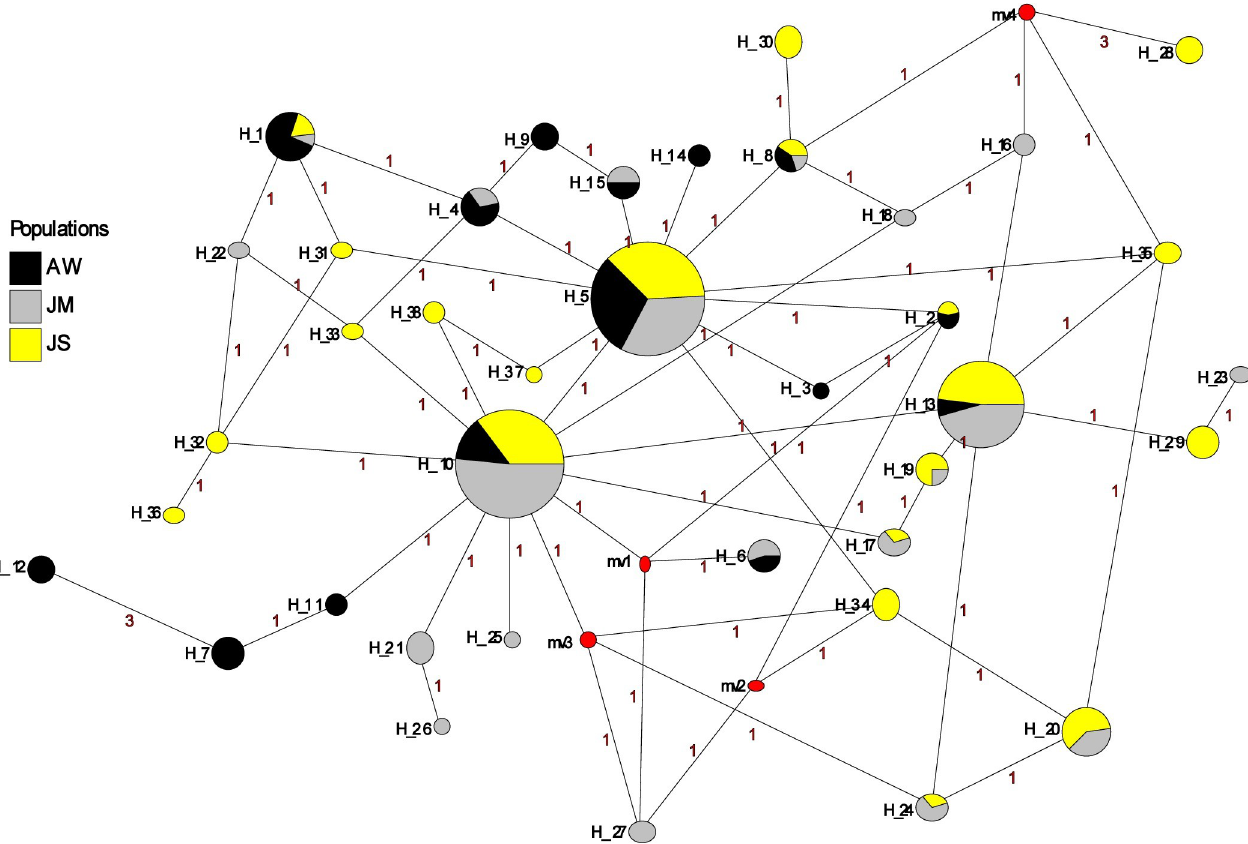
Fig 6. Median-joining network for PpSP14 P . papatasi haplotypes. Circle size and circle color indicates frequency and geographical location of haplotypes, respectively. Haplotype numbers are indicated next to the corresponding circle H_XX. Red numbers between haplotypes indicate number of mutations between haplotypes.